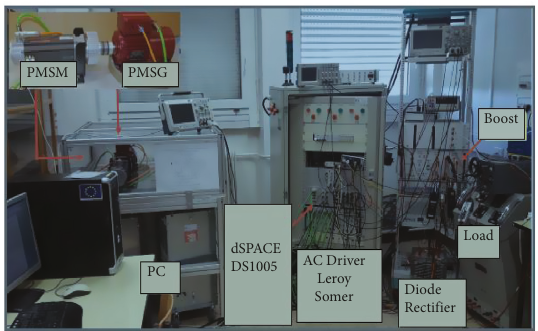
Figure 7: Experimental test bench schema of the wind turbine